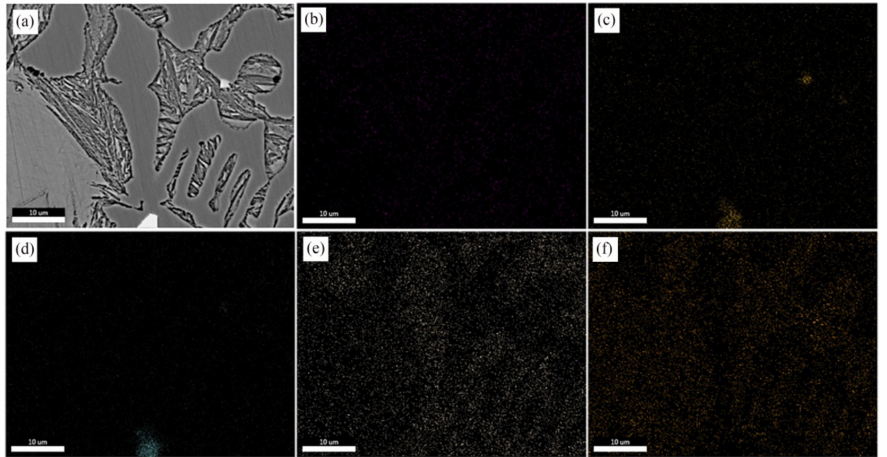
Figure 5. EDS mapping after adding a 0.30 wt % (NbTi)C sample: ( a ) SEM; ( b ) C; ( c ) Nb; ( d ) Ti; ( e ) Cr; ( f )